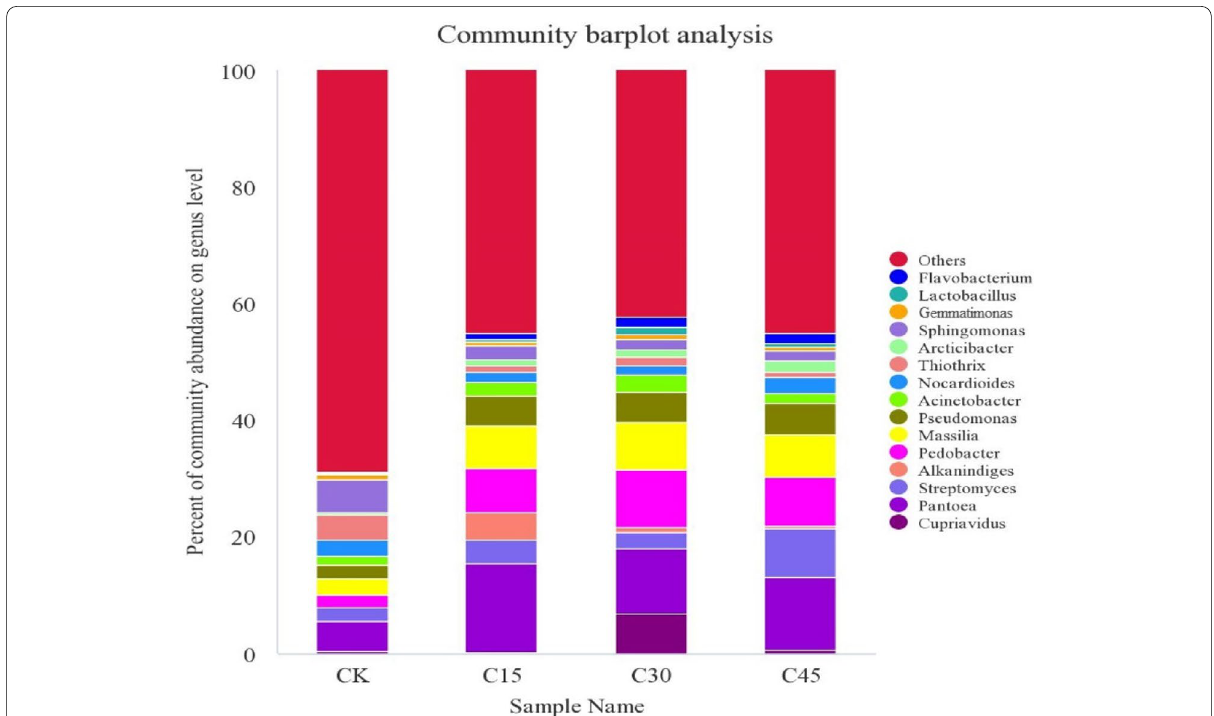
Fig. 6 Community composition characteristics of soil microorganisms at different genus